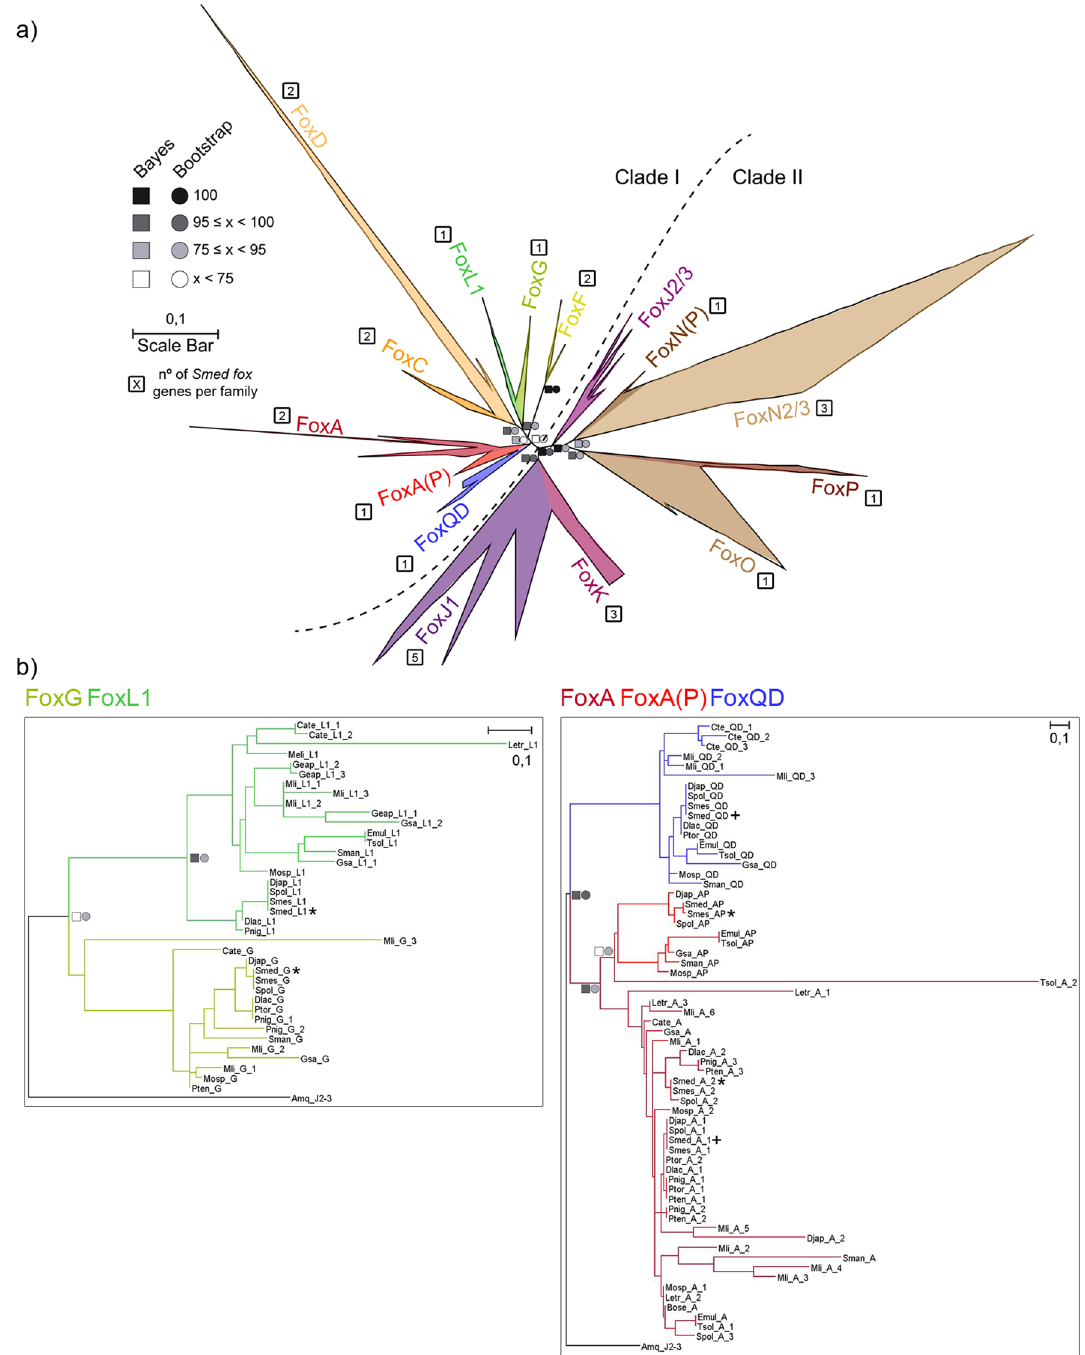
Figure 3. Fox family evolution in Platyhelminthes indicates family diversification. ( a ) The ML phylogenetic trees based on FKH of Fox family evolution in Lophotrochozoan clade. Number of genes per family in Schmidtea mediterranea is indicated inside a square next to each family. At nodes, values for the approximate Bayes (square) and Likelihood (circle) ratio test are shown. Colour indicates % of confidence. Family tree branches were collapsed at the base of the common node. Dashed line divides Clade I and Clade II Fox genes. ( b ) For each node-sharing families, a phylogenetic tree was created using an Amq gene from the opposite clade as out group. Family branches are painted with the same colour as they are represented in the trees. Dark cross indicates previous characterized gene and dark asterisk indicates new fox characterized in Schmidtea mediterranea ( Smed ). Aminoacidic sequences used are placed in S3 File. Scale indicates expected aminoacidic substitution per